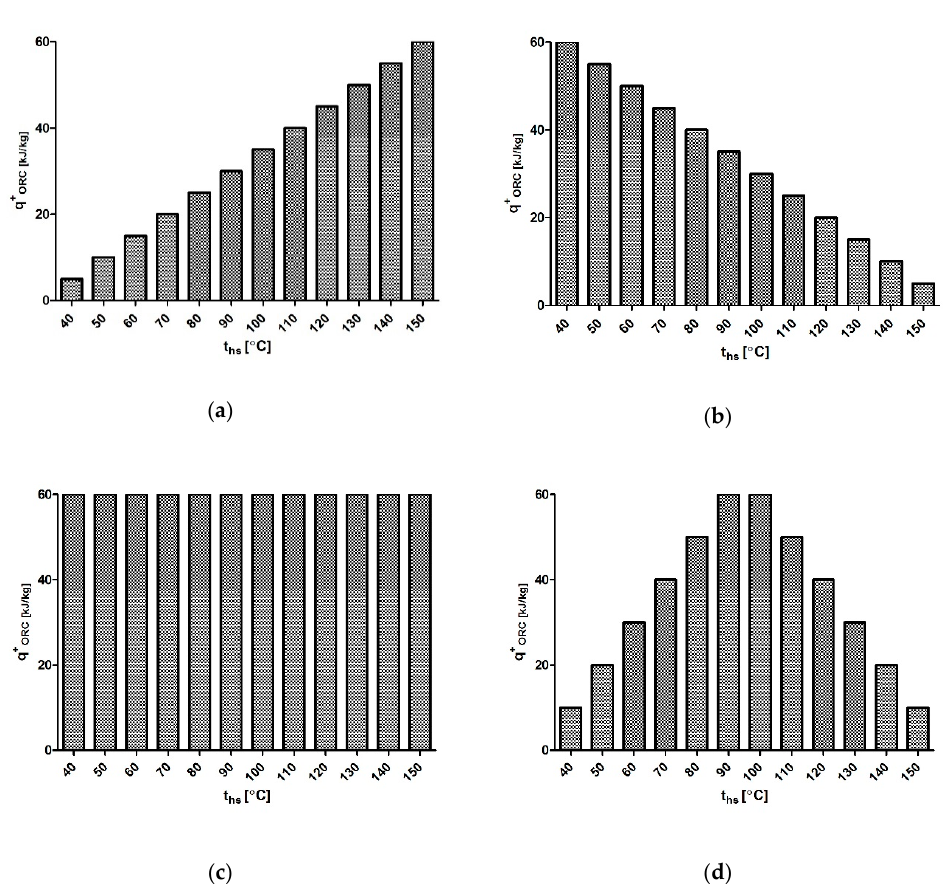
Figure 5. Histograms of different heat sources: ( a ) ascending; ( b ) descending; ( c ) constant; ( d ) parabolic.